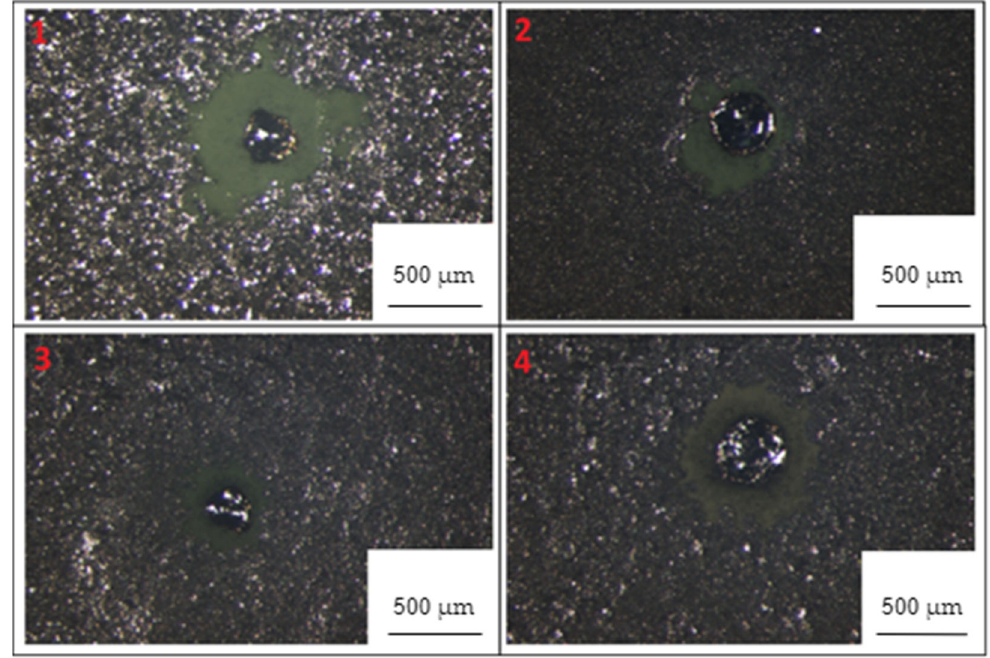
Figure 6. Damages of samples by electric discharge 1–4 (sorted following Table 3).